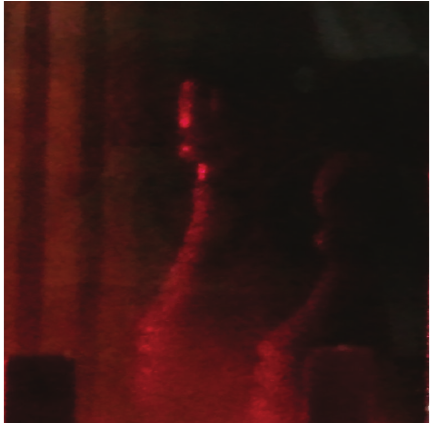
Figure 3: The reconstructed virtual image.